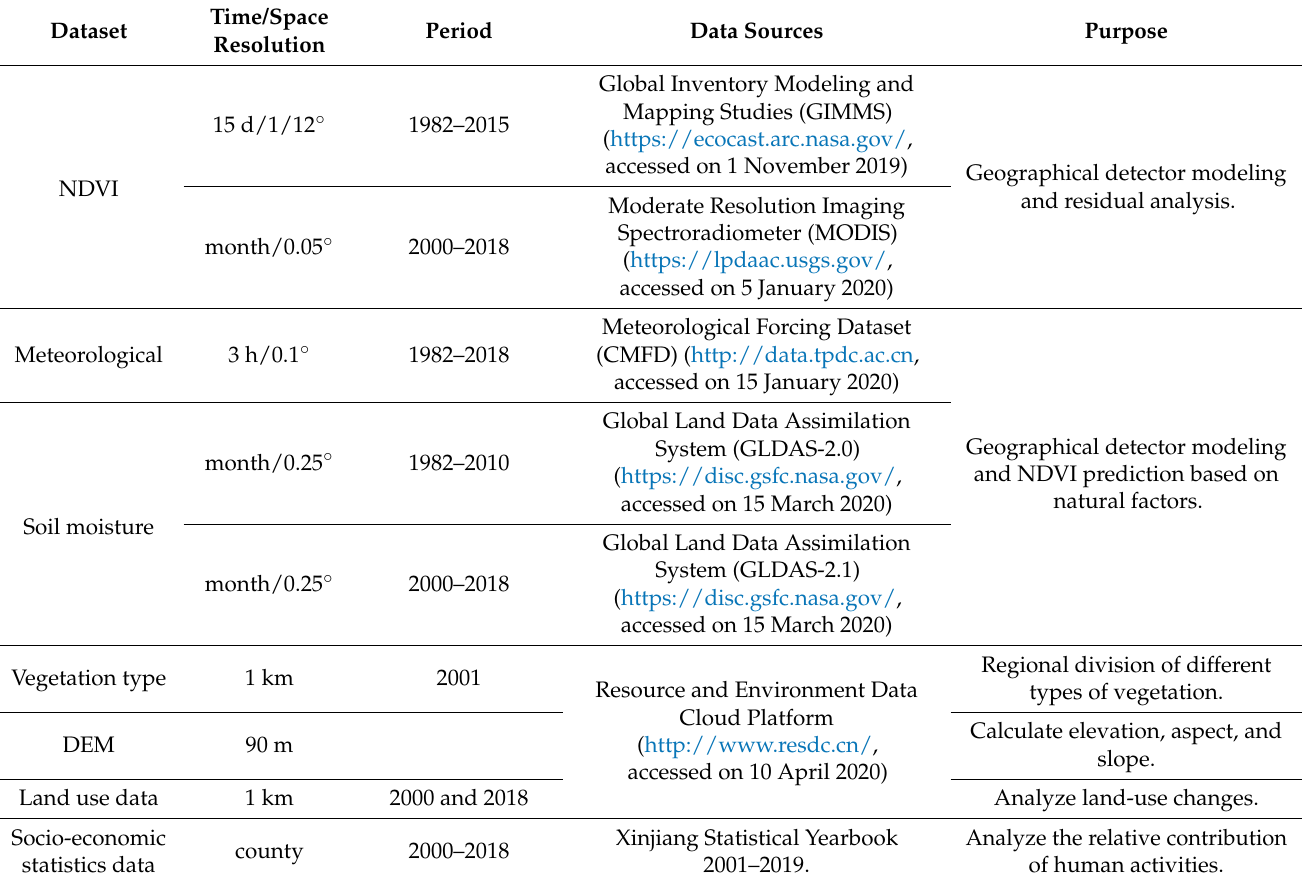
Table 1. Summary of the data sources used in this